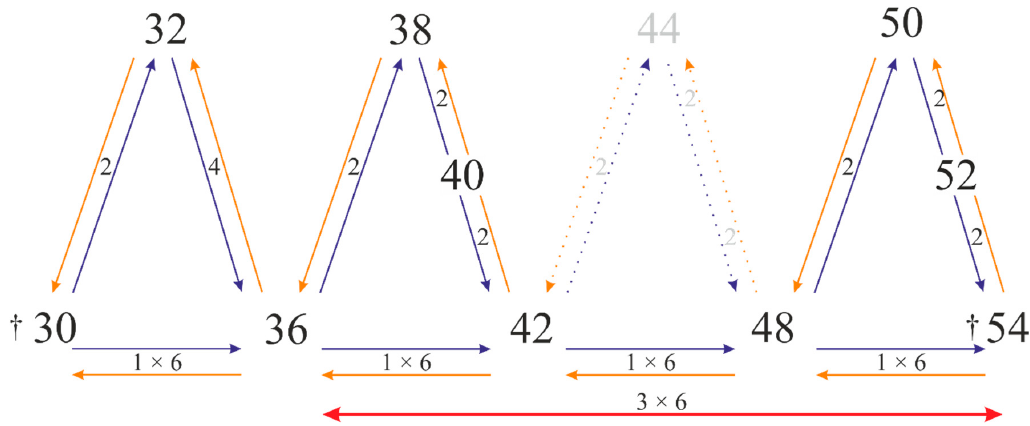
Figure 7. Hypothetical pattern of direction of lupin chromosome evolution through polyploidy and aneuploidy events. † describes extinct species; considering x = 6 the 1 × 6 corresponds to one round of whole genome duplication (WGD), while 3 × 6 three rounds of WGD; number 2 (4) indicates the aneuploidy events.